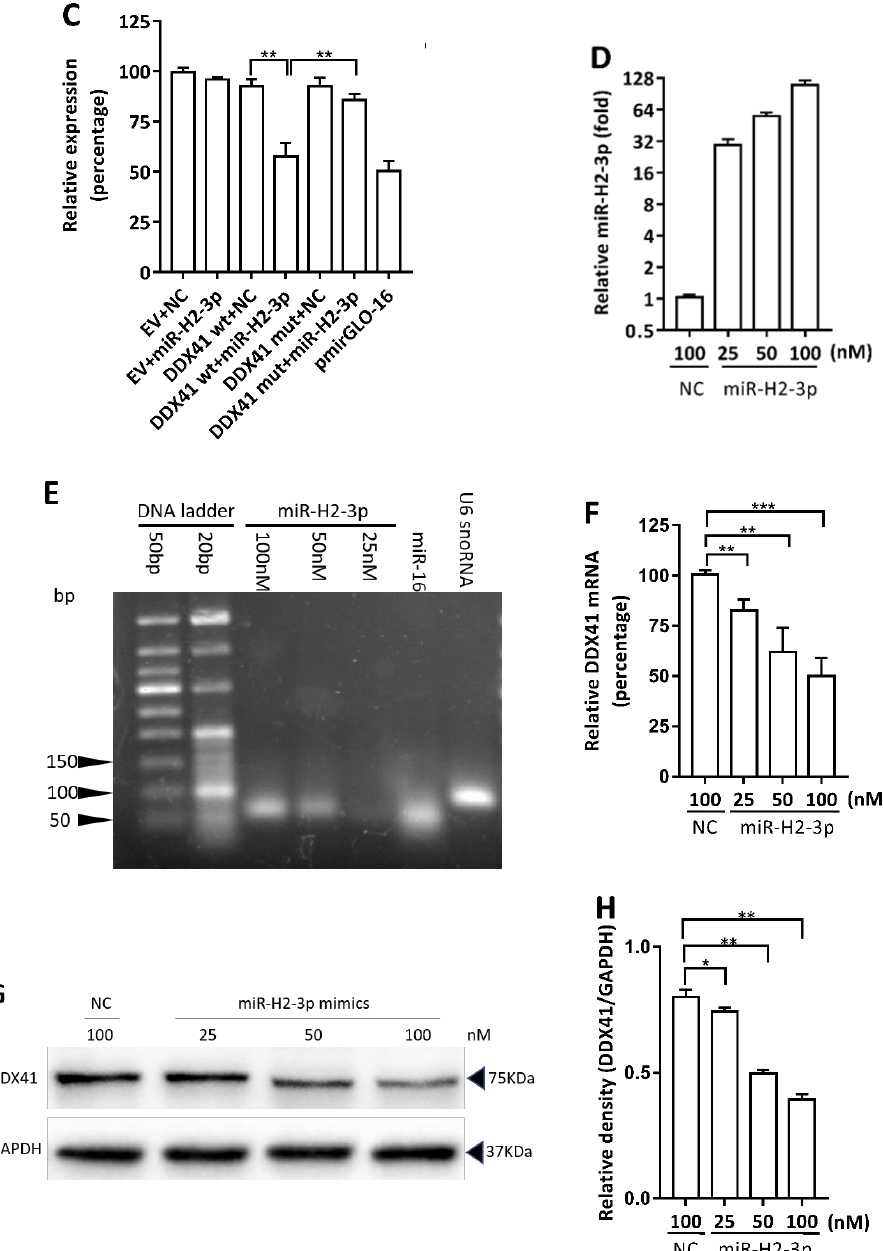
Figure 2. miR-H2-3p targeted DDX41 directly. ( A ) Sequence alignment of DDX41 from different species for conservative analysis. The seed region binding within DDX41 in the big black rectangular frame, especially G:U wobble base pairs in the small black rectangular frame. ( B ) Sequence alignment of miR-H2-3p and its binding sites in the 3 (cid:48) -UTR of DDX41. The seed sequence in the 5 (cid:48) region of miR-H2-3p is shown in the black rectangular frame, pairing nucleotides in black short sticks or black short dashed line (only for G:U wobble base pairs), mutant sites in black short arrows. ( C ) HEK-293T cells were co-transfected with empty plasmid (EV), pmirGLO-DDX41-3 (cid:48) -UTR wild-type (DDX41 wt) plasmid, pmirGLO-DDX41-3 (cid:48) -UTR mutation (DDX41 mut) plasmid, and miR-H2-3p mimics (miR-H2-3p) or NC as indicated. After 24 h of transfection, the cells were harvested and dual-luciferase reporter assay was performed. The values were standardized to 100% in the EV + NC groups. Data are the means ± SD ( n = 3) from one representative experiment. Similar results were obtained from